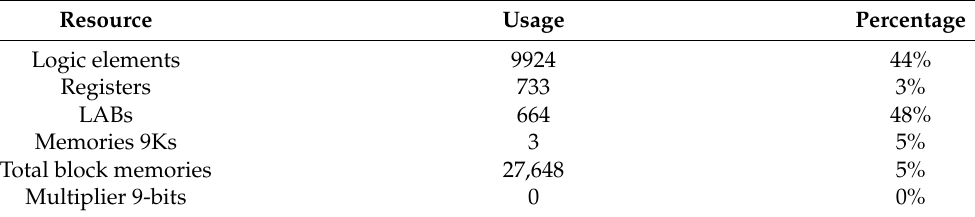
Table 2. Summary of the FPGA resource usage after placement and routing.